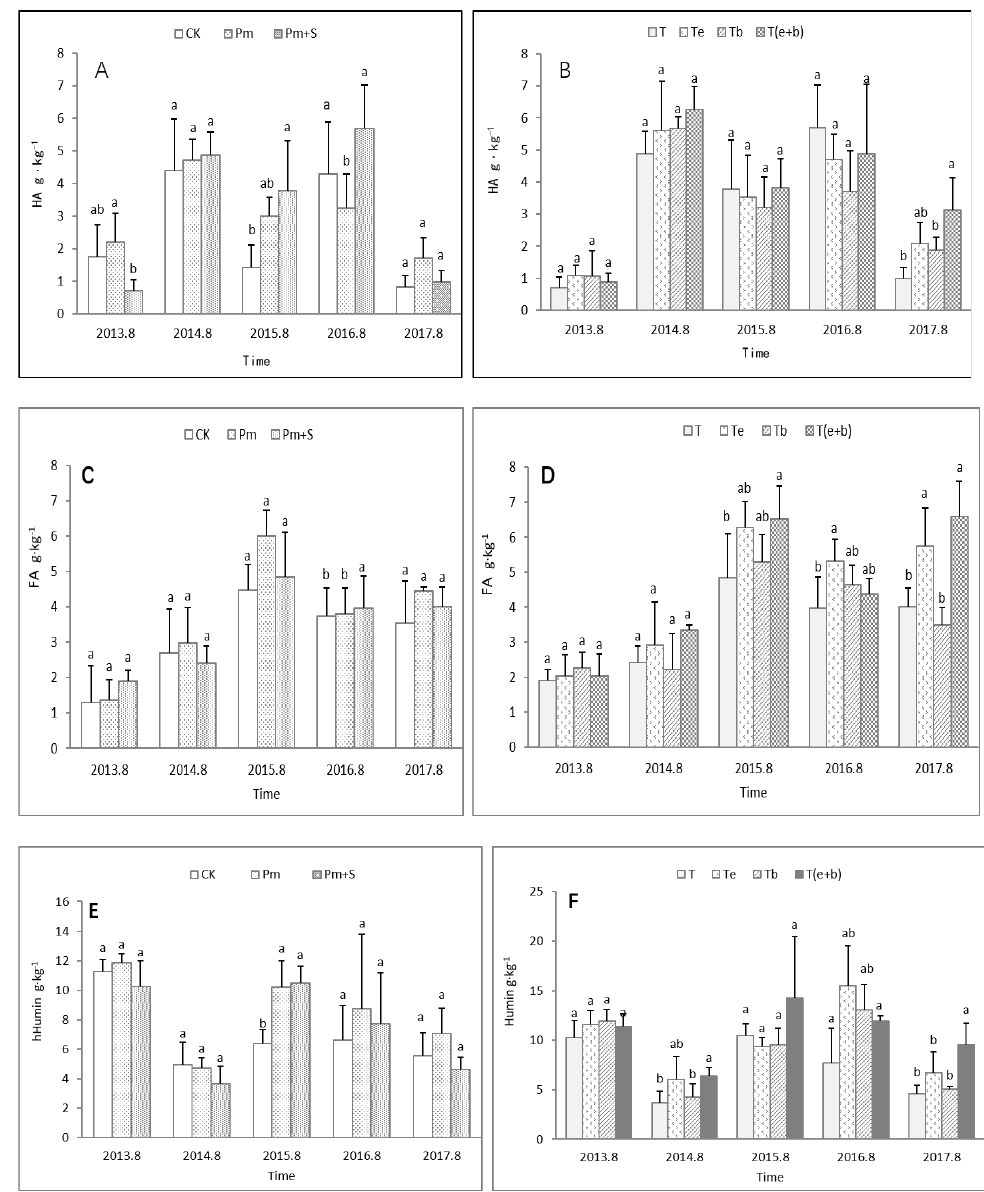
Figure 8. Dynamic changes of soil humus content. Bars represent standard errors. Lower case letters above each panel show statistical signif-icance at p < 0.05. CK pig manure, S slurry, e earthworms, b bacteria, T Pm + S, Te T + earthworms, Tb T + bacteria, T(e + b) T + earthworms + bacteria ( A ) Pig manure, biogas slurry agricultural use ( B ) Biological control ( C ) Pig manure, biogas slurry agricultural use ( D ) Biological control ( E ) Pig manure, biogas slurry agricultural use ( F ) Biological control.